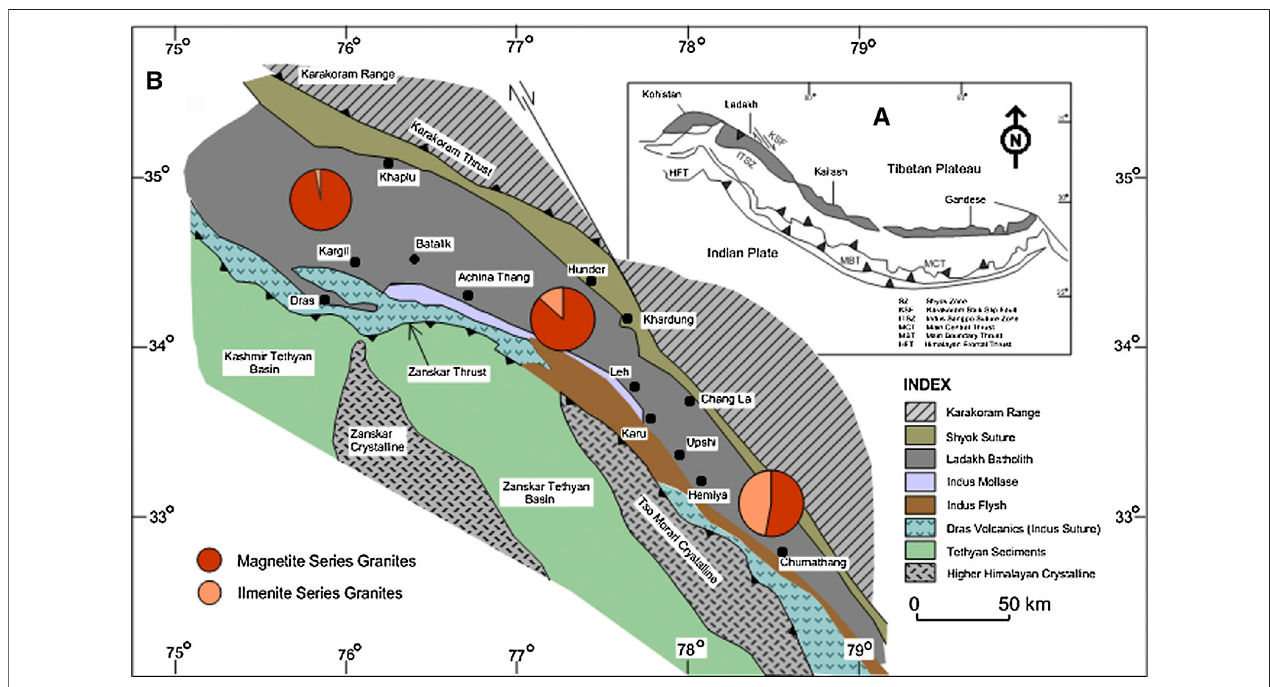
FIGURE 1 | (A) Geological structure of Himalaya showing the tectonic elements, Trans-Himalayan magmatic arc and location of the Ladakh Batholith (after Gansser, 1977). (B) Geological map of Ladakh Himalaya (after Sharma and Chaubey, 1983; Thakur, 1987). Relative abundance of magnetite series and ilmenite series granites in western, central and eastern parts of the Ladakh Batholith is shown by wheel diagrams (Kumar, 2008; Kumar, 2010b).